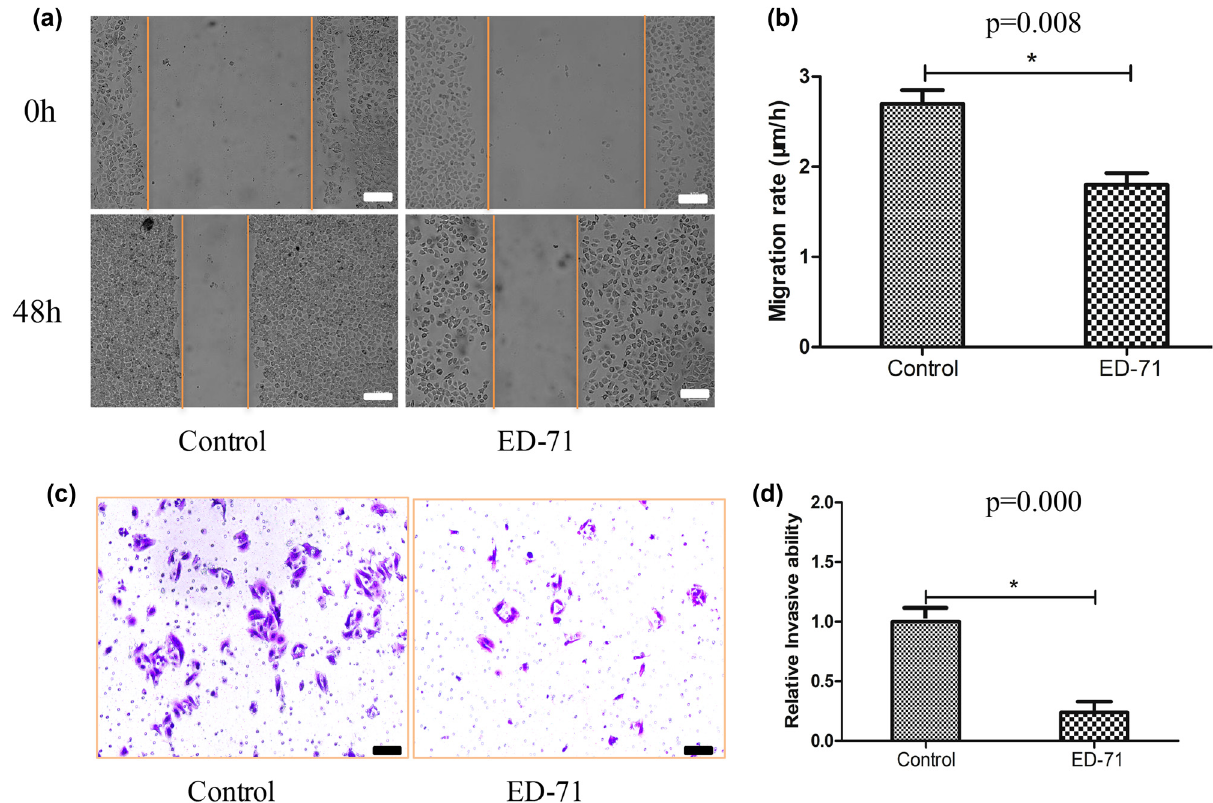
Figure 1: ED - 71 ( 0.5 nM ) markedly inhibited the migration and invasion of liver cancer cells. ( a ) Representative pictures of cell migration after treatment with ED - 71 ( scale bar: 150 µm ) ; ( b ) quanti fi cation analysis of cell migration after treatment with ED - 71; ( c ) representative pictures of cell invasion after treatment with ED - 71 ( scale bar: 30 µm ) ; ( d ) quanti fi cation analysis of cell invasion after treatment with ED - 71. * P < 0.05 compared with the control